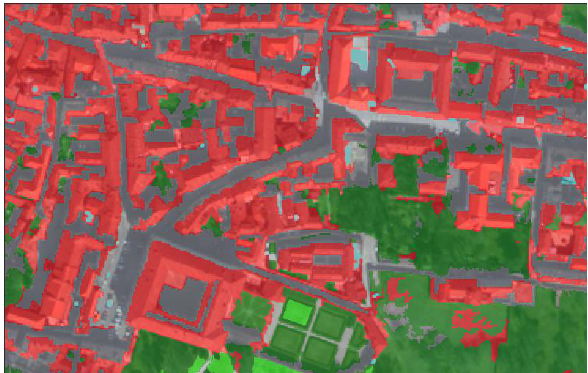
Figure 17. Same area after the classification with Bayes algorithm.